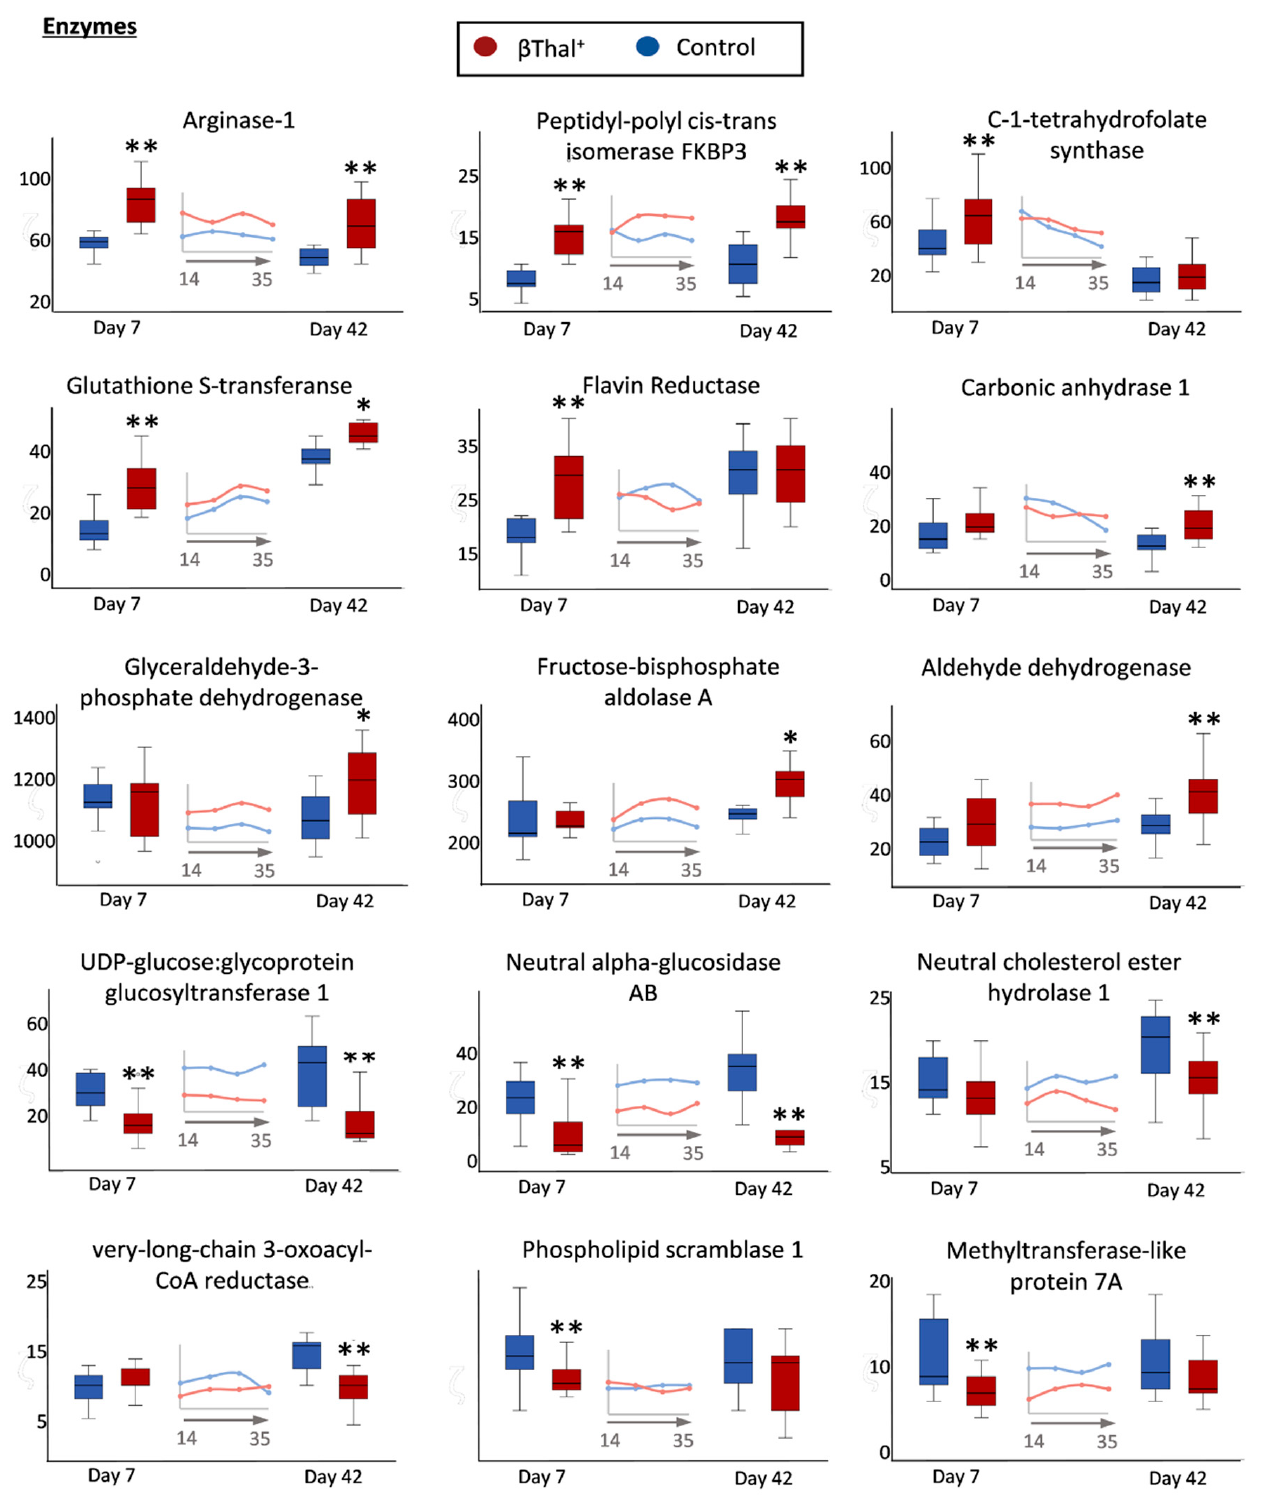
Figure 5. Proteomics analysis of stored RBC membrane: proteins with enzymatic activity. Levels of integral membrane enzymes or cytosolic membrane-bound enzymes in β Thal + and control RBCs throughout storage. Inserts: pooled analysis of membrane samples at weekly intervals. (*) p < 0.05 β Thal + vs. controls; (**) p < 0.05 and fold > 1.25 β Thal + vs. controls.